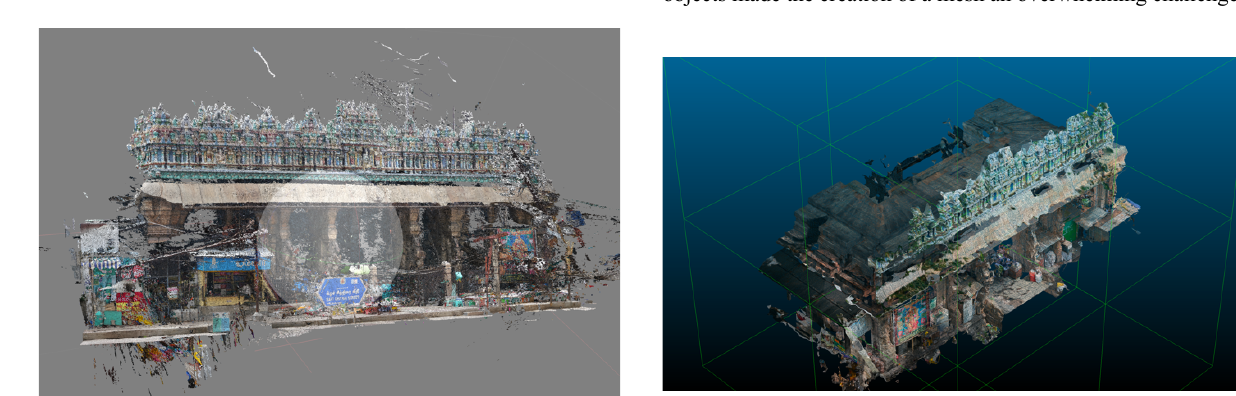
Figure 9. Pointcloud of the West front of the Pudhu Mandapam derived from traditional photogrammetry using © Agisoft Metashape Pro